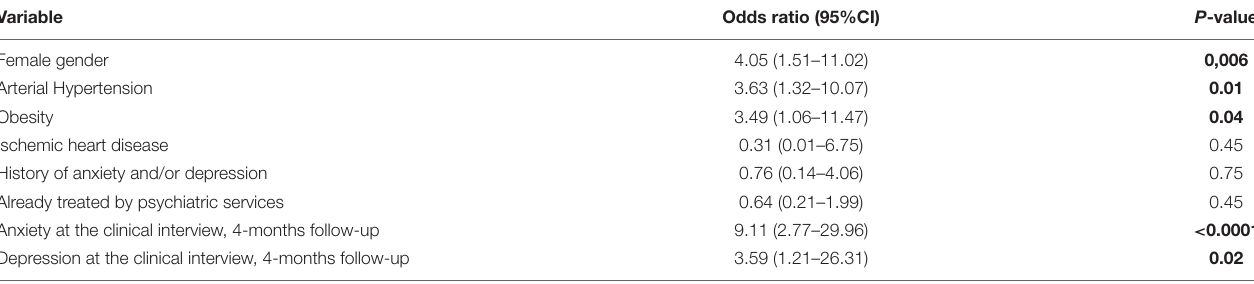
TABLE 3 | Logistic regression model—anxiety at 12 months.